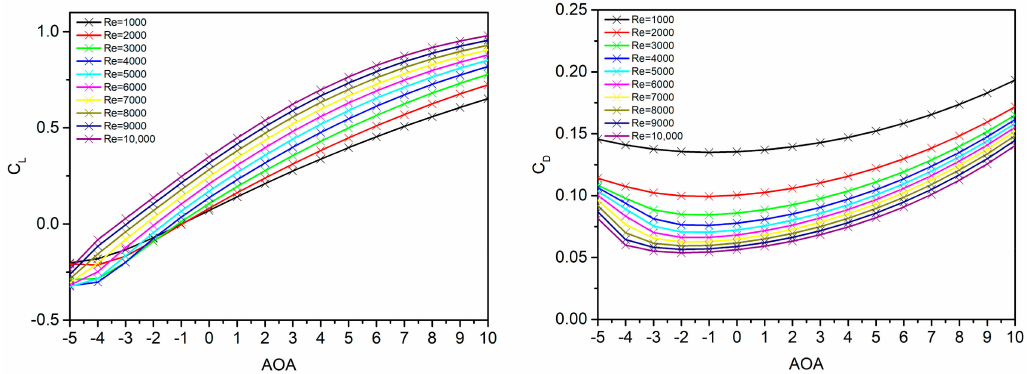
Figure 7. FX63 airfoil performance for Re =